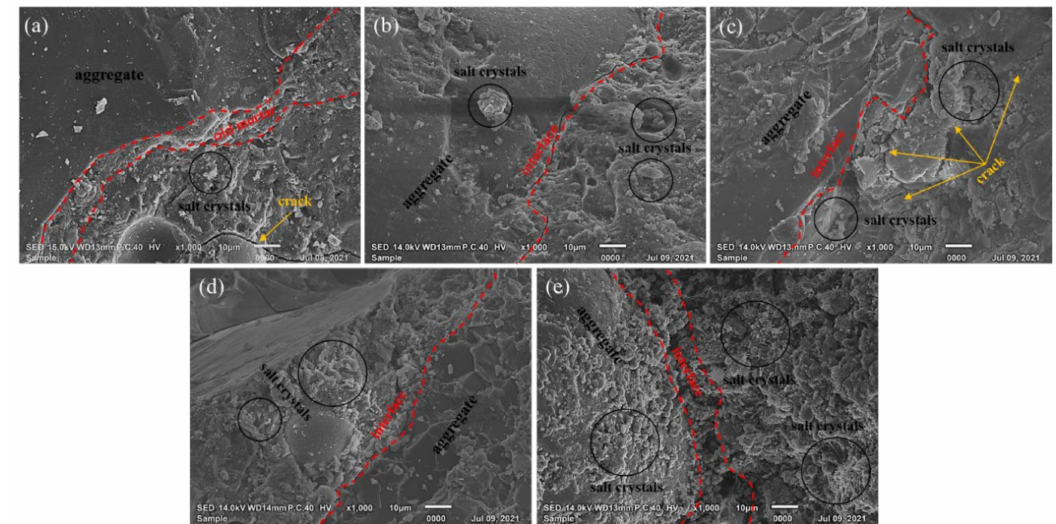
Figure 12. SEM images of RAC and MSRAC with medium– and low–quality MS after the RCM test: ( a ) RAC; ( b ) MS2–50; ( c ) MS2–100; ( d ) MS3–25; ( e )